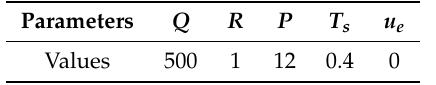
Table 3. Parameters in model predictive control (MPC).